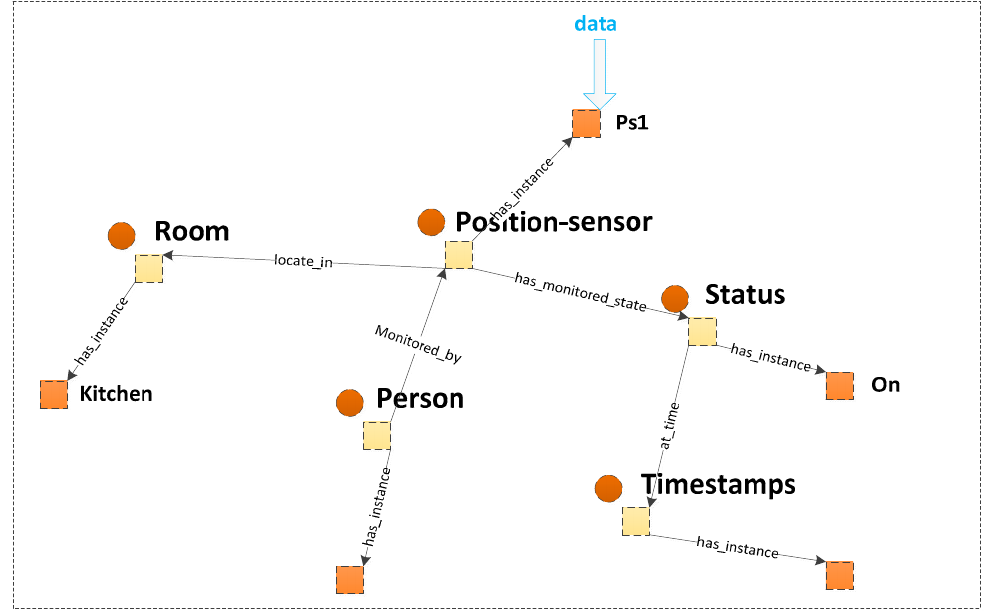
Figure 15. An example of the updated ontology with position sensor data.